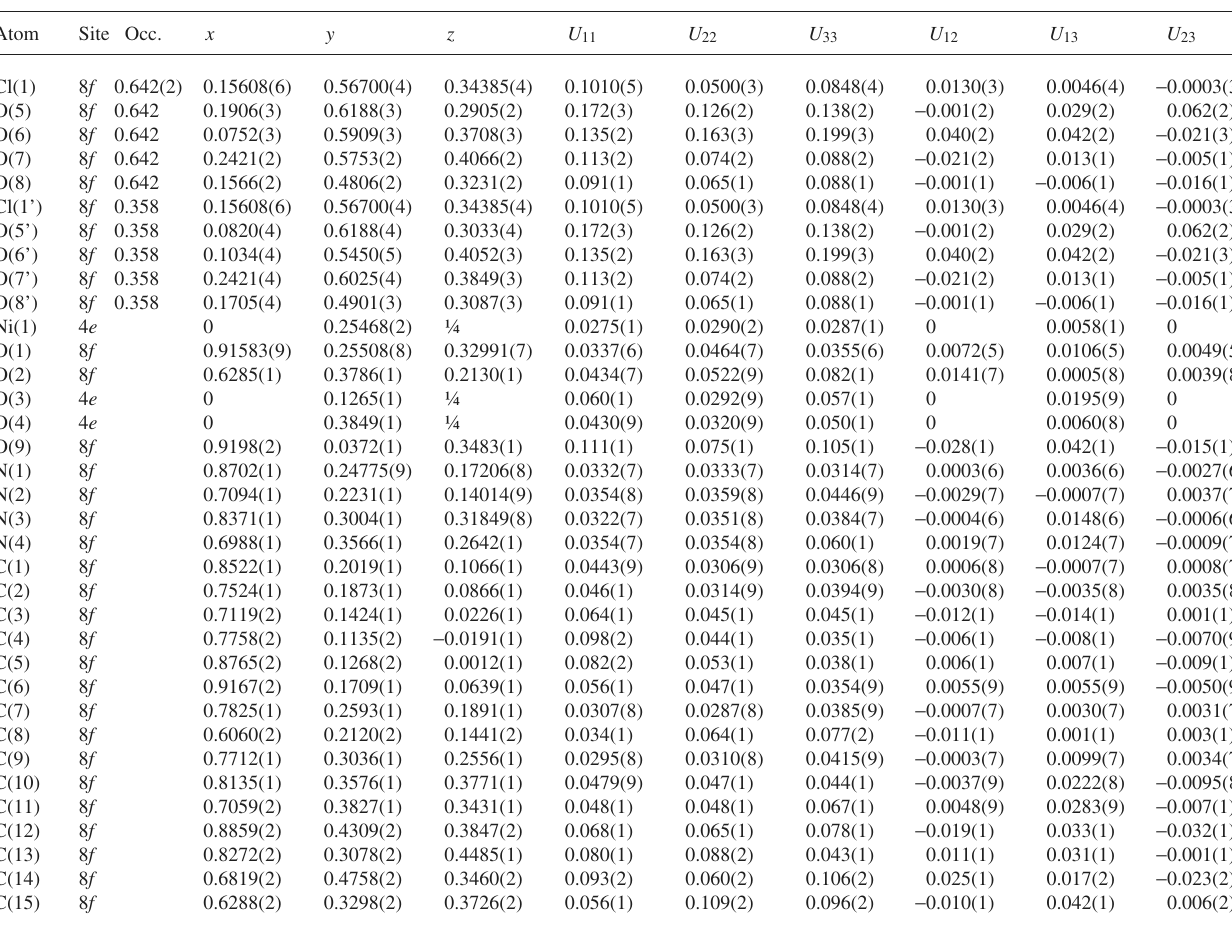
Table 3. Atomic coordinates and displacement parameters (in Å 2 ) .